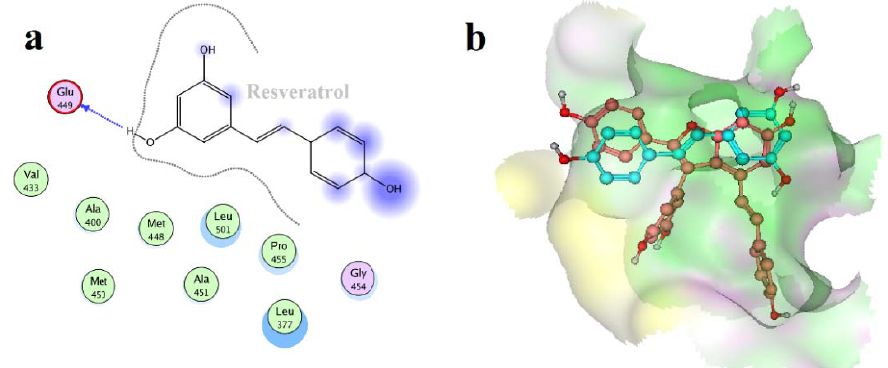
e 11. ( a ) ) The tw wo-dimensio onal projec ( b ) Su uperposition n of MD ave erage struct tures of resv Syk (p pink).